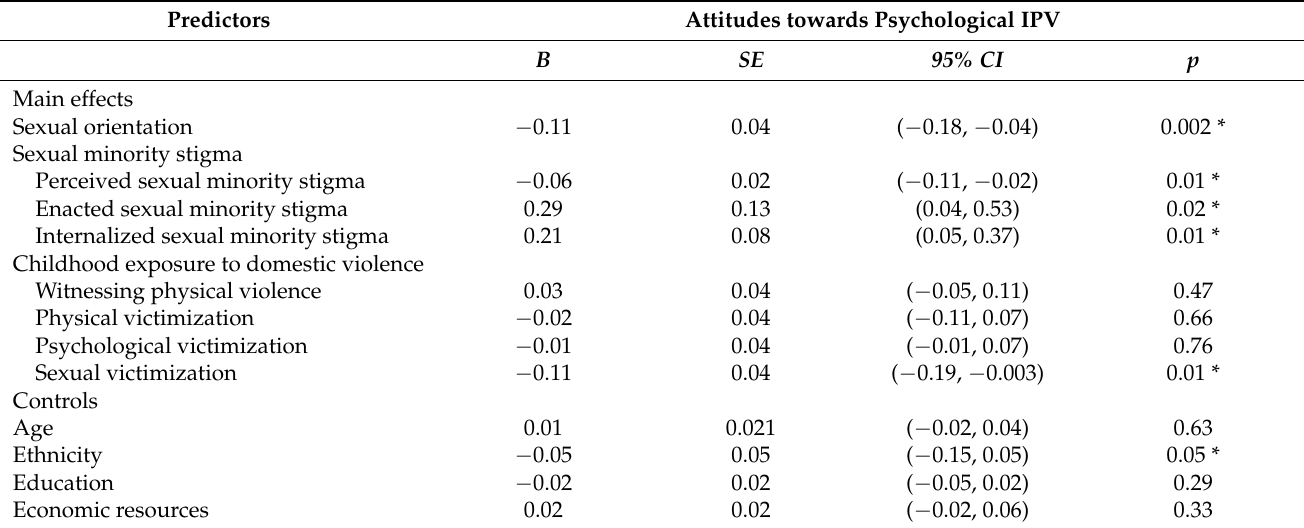
Table 4. Regression coefficients for predicting perceptions of psychological intimate partner